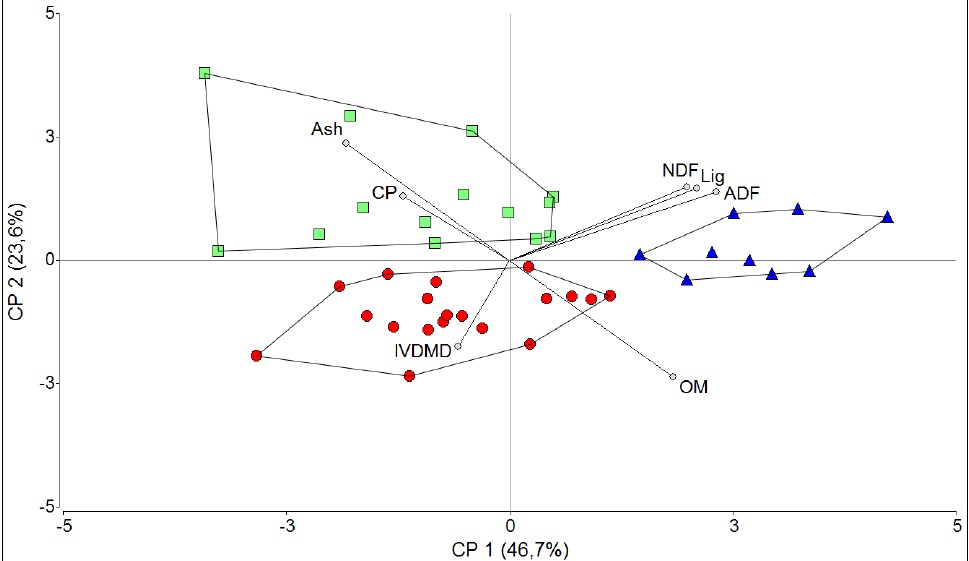
Figure 4. Biplot obtained by PCA of nutritional quality variables of the plants included in the